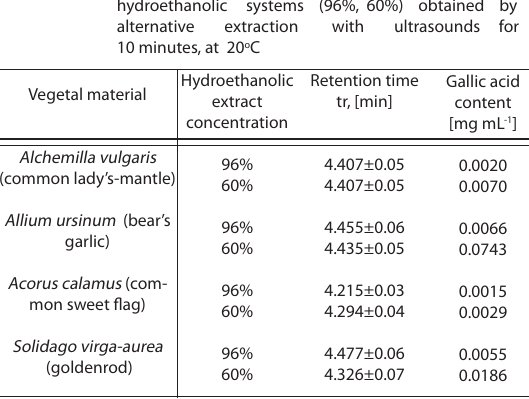
Table 2. Retention times and